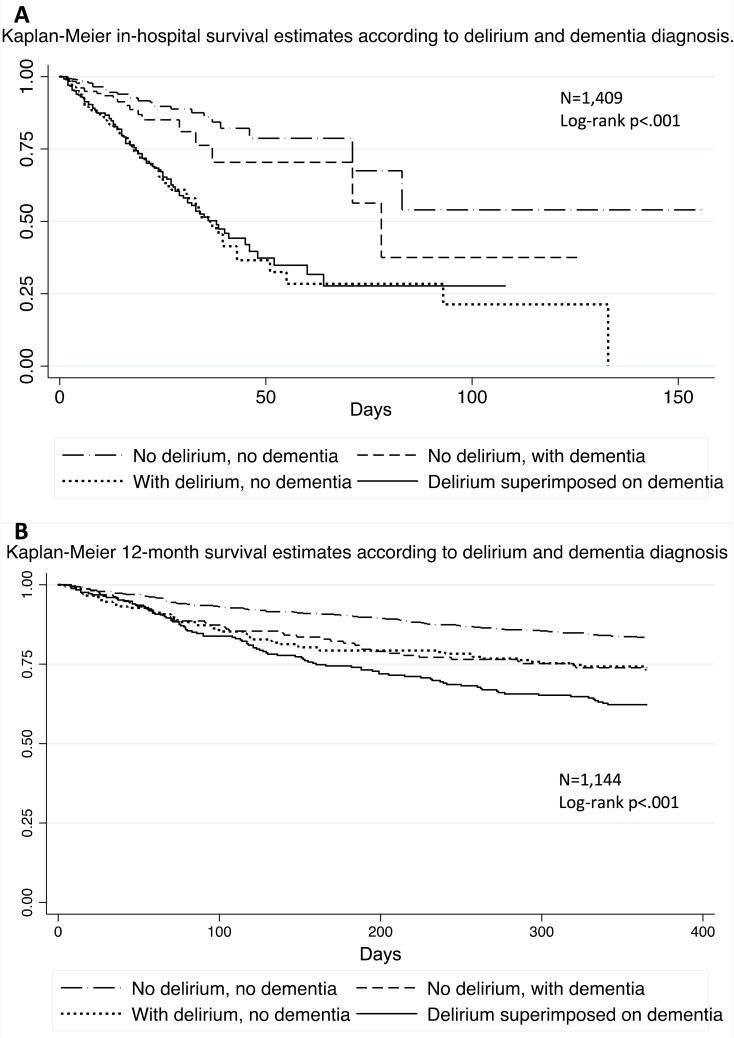
Probability of survival according to delirium and dementia diagnosis.(A) Kaplan–Meier estimates representing the probability of survival in the hospital according to delirium and dementia diagnosis, with a corresponding log-rank test indicating a statistically significant difference between the groups. (B) Kaplan–Meier estimates representing the probability of survival over 12 mo according to delirium and dementia diagnosis, with a corresponding log-rank test indicating a statistically significant difference between the groups.